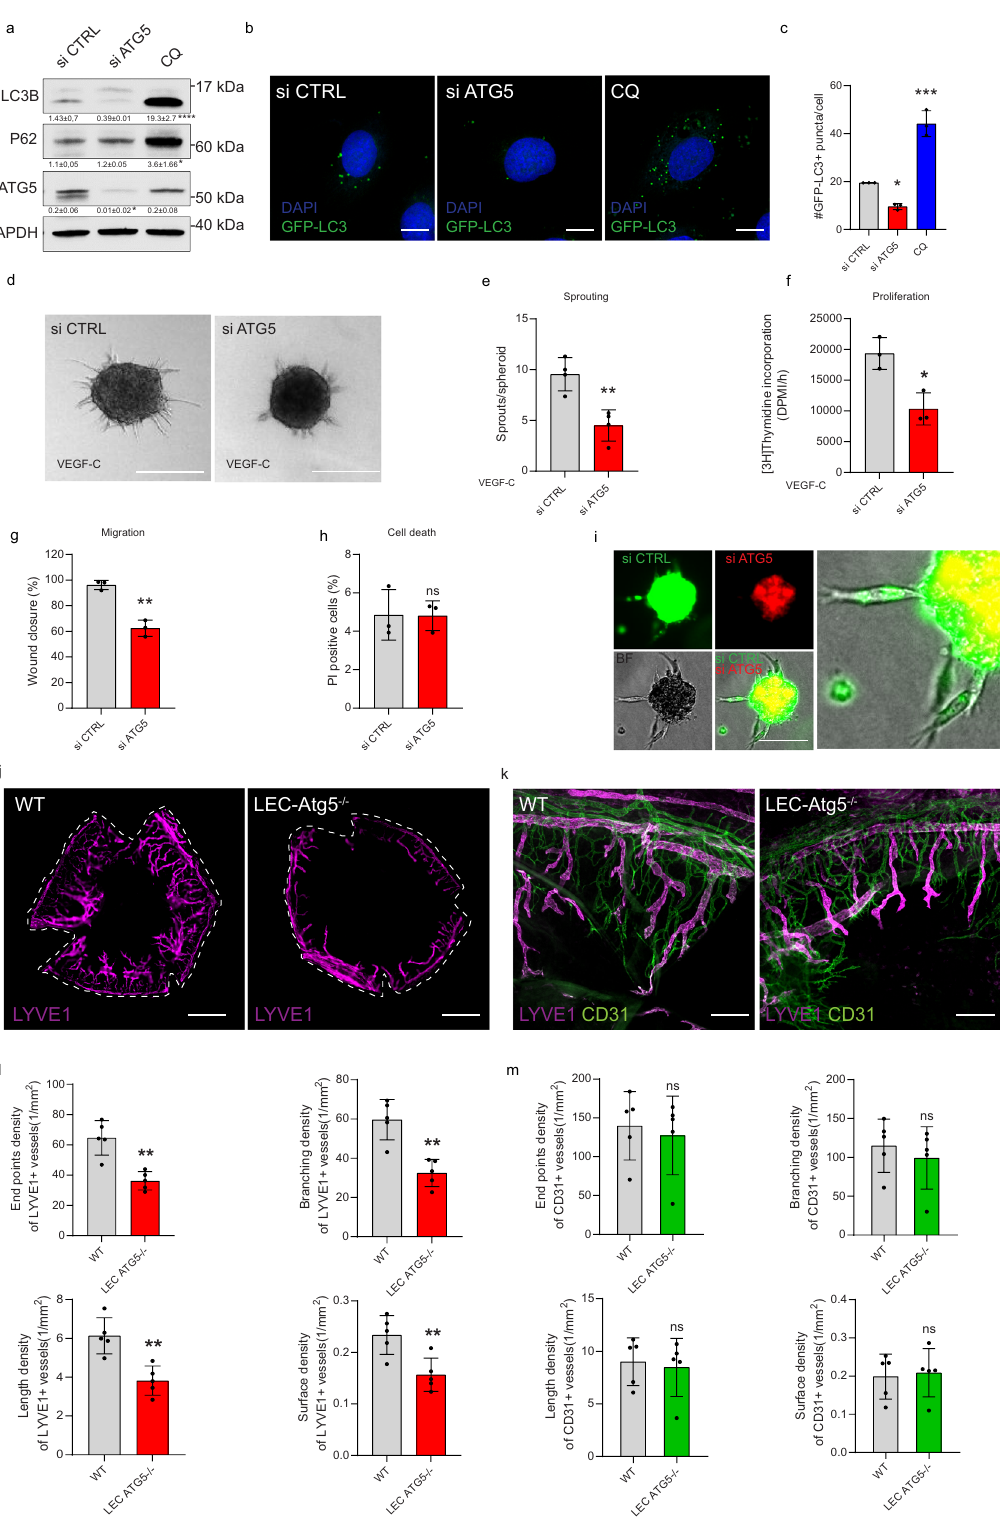
downregulation of key LEC markers, we then evaluated the effects of autophagy depletion on their RNA expression. Matching the effects observed on the protein levels, the knockdown of ATG5 (Fig. 2d – g), ULK1 (Fig. 2h – k), ATG7 (Supplementary Fig. 2c – f) or CQ treatment (Fig. 2d – g) in LEC lowered the RNA expression of VEFGR3 and all tested lymphatic markers, in vitro. Consistent with their curbed response to injury-driven lymphangiogenesis, as